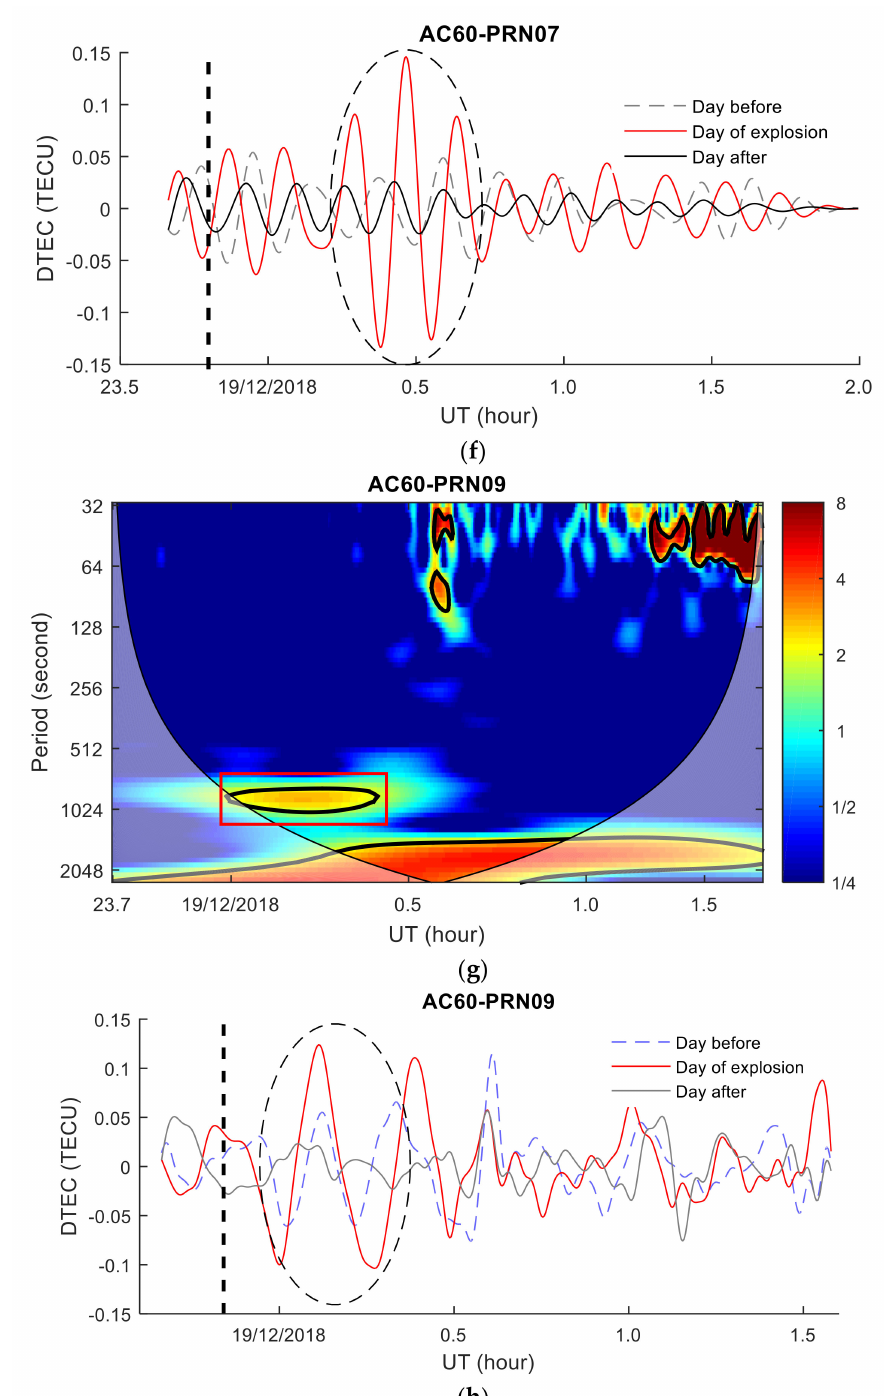
Figure 6. TEC disturbance variations and wavelet transform power spectrum. ( a , c , e , g ) are the power spectra of the TEC time series wavelet transform. The red rectangle is the TEC disturbances area, and the thick black line is the area that passes the 95% confidence test. ( b , d , f , h ) are TEC disturbances variations graphs. The black dotted line indicates the moment of the meteor explosion, the ellipse indicates the disturbances, the blue dotted line indicates DTEC ( t ) the day before the explosion, and the black line indicates DTEC ( t ) the day after the explosion). Shadow region regions on either end indicate the “cone of influence”, where edge e ff ects become